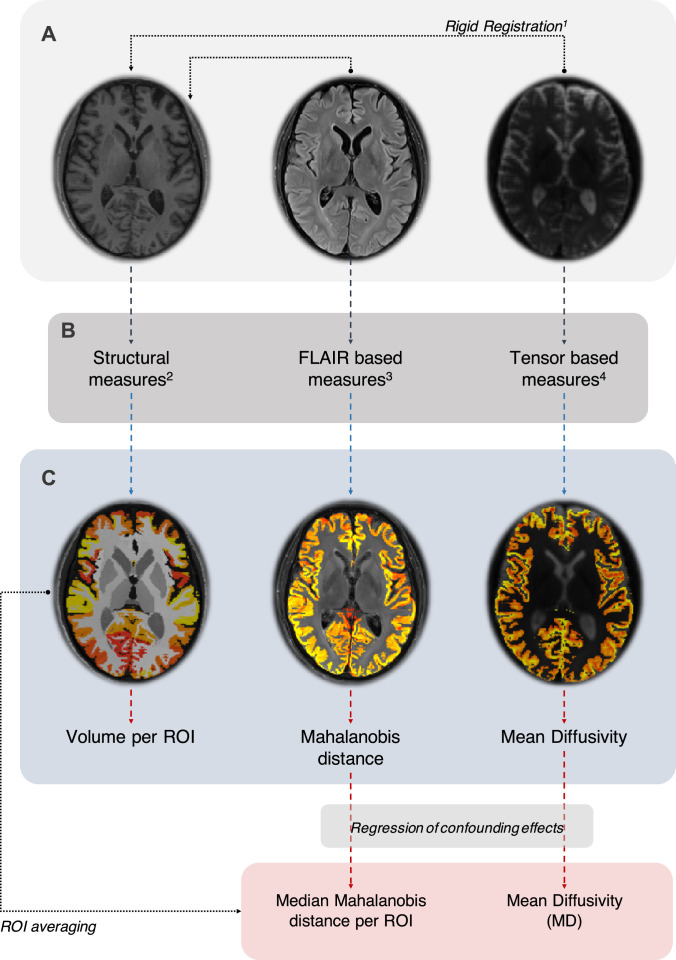
Representation of the framework adopted for feature extraction. A: data preprocessing step, including rigid registration using (1) NiftyReg Modat et al. (2014). B: Feature extraction per MRI sequence, applying (2) GIF algorithm (Cardoso et al., 2011) to T1, using (3) BaMoS algorithm to extract the intensity distributions of FLAIR (Sudre et al., 2015), and computing the diffusion tensor from DWI. C: Quantitative features computed from the images obtained in the section B of the framework.